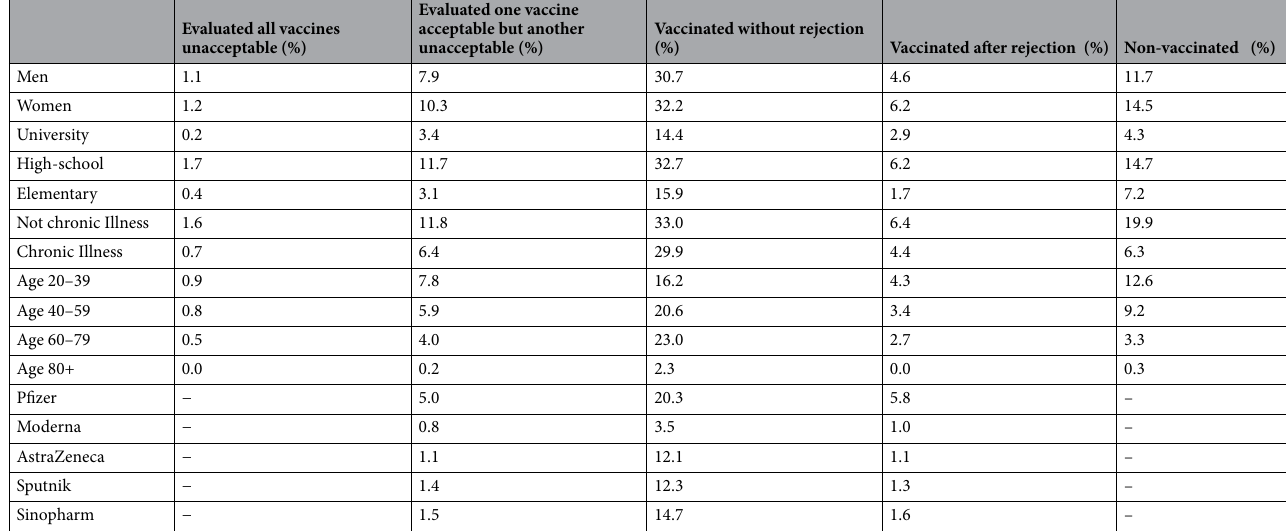
Table 1. Percentage of individuals in the sample by major socio-demographic characteristics and COVID vaccination history. Percentages in the last three columns add up to 100 % by character groupings (except the rows on specific vaccine types where the last column is not relevant). In the last section of rows, we classified the individuals by the accepted vaccine type.